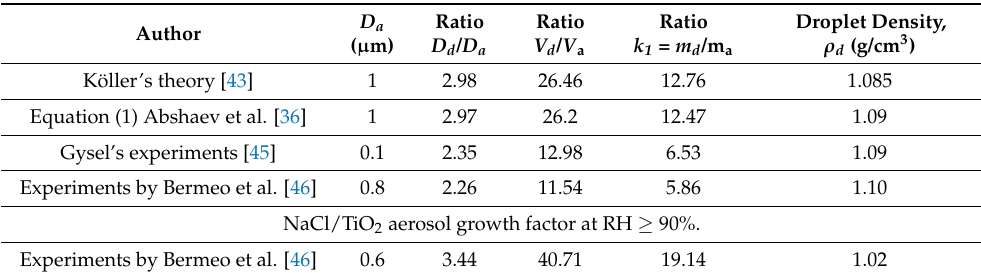
Table 1. NaCl aerosol growth factor at RH ≥